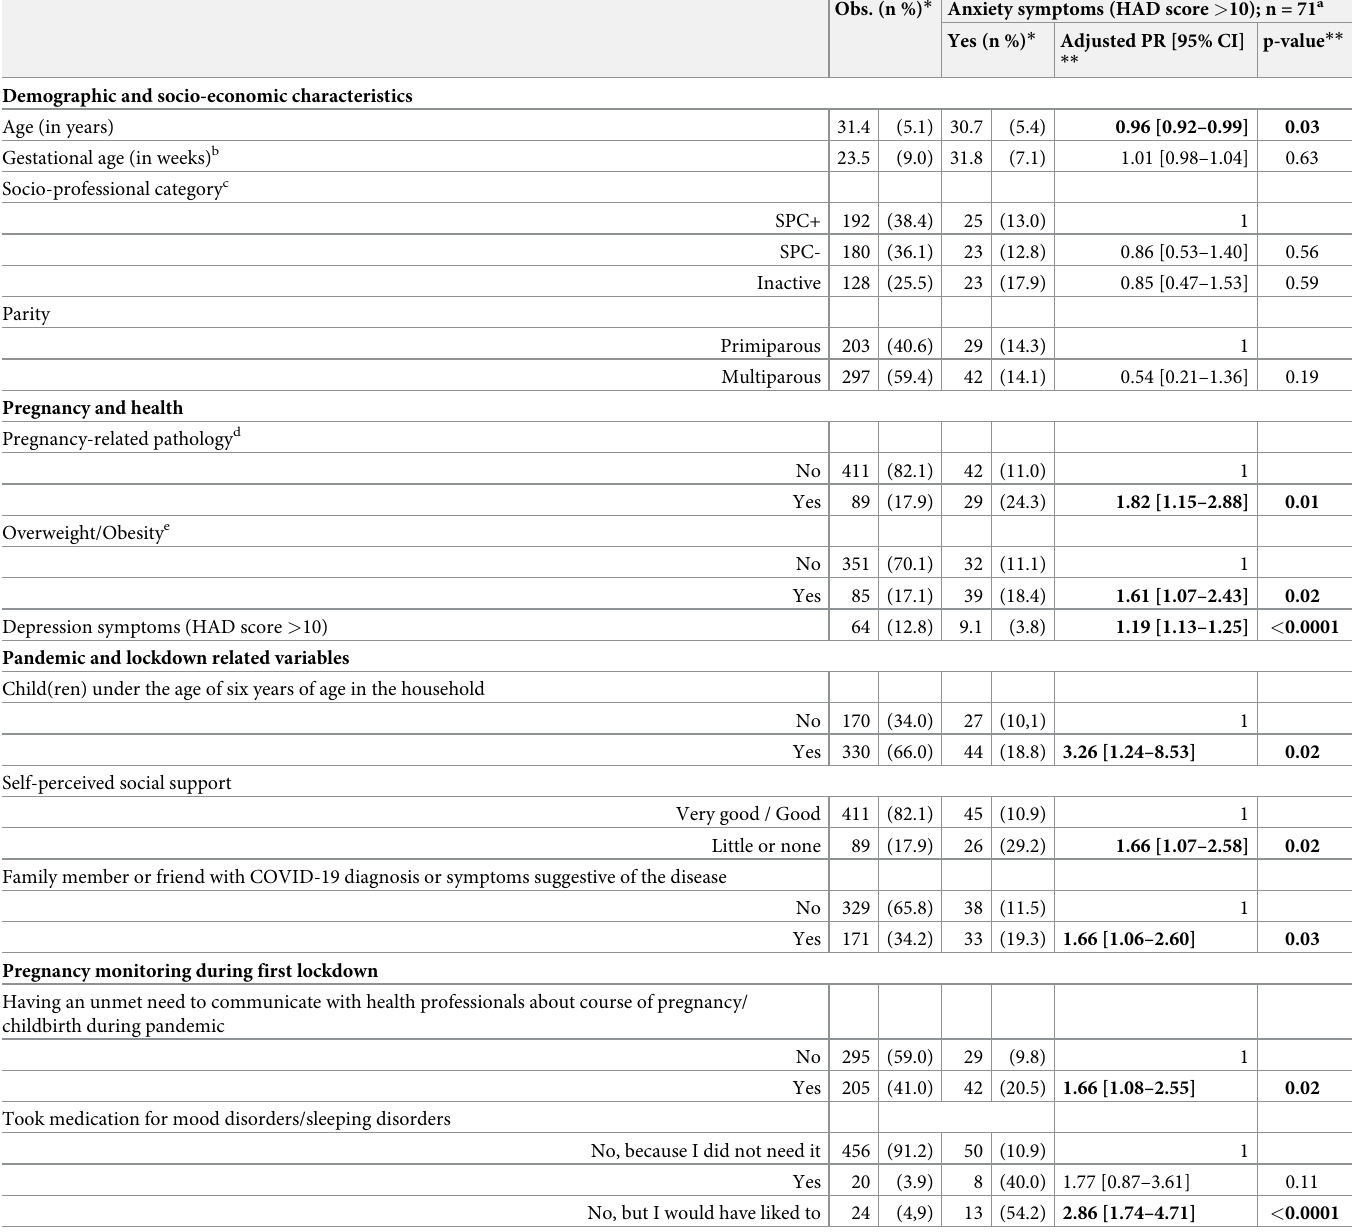
Table 3. Factors associated with anxiety symptoms frequency (defined as an HAD score > 10) two months after the first SARS-CoV-2 pandemic lockdown ended in pregnant women who participated in the Covimater survey (n = 500), France (July 2020). Obs. (n %) * Anxiety symptoms (HAD score > 10); n = 71